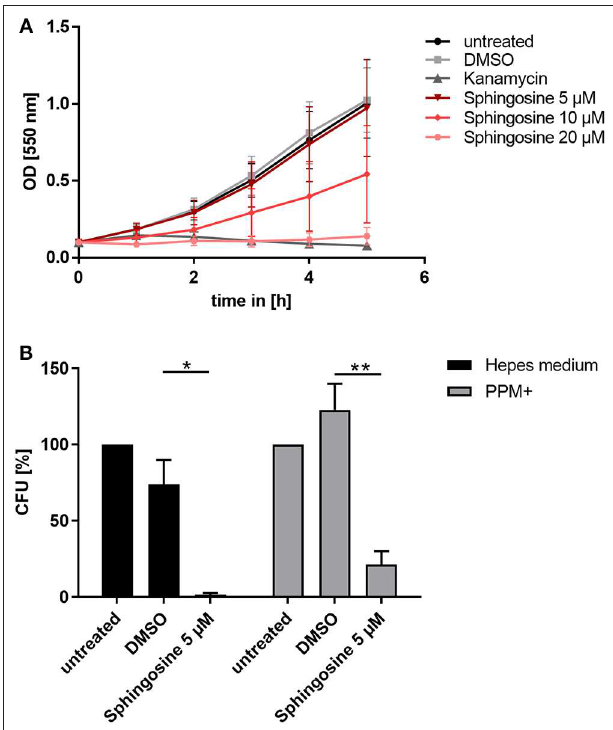
FIGURE 3 | Toxic effect of sphingosine on N. gonorrhoeae N927. (A) Effect of different sphingosine concentrations on N927 in vitro . (B) Liquid cultures of N927 in Hepes medium or PPM + were incubated with 5 µ M sphingosine or DMSO as solvent control for 2h and dilutions were then plated on GC agar plates. Plates were incubated for 24h and CFUs were counted. Error bars show the mean ± SD of three independent experiments. * p < 0.05, ** p < 0.001 student’s t -test relative to untreated